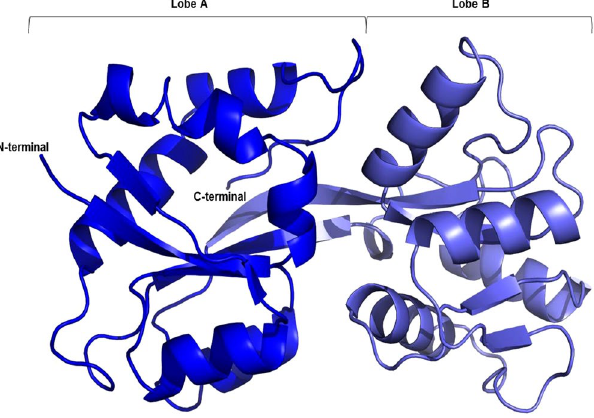
Figure 1. Cartoon representation of the DaG2 0 TupA tertiary structure. The different colors represent the two lobes, A in blue and B in light blue. Picture prepared with Pymol 50